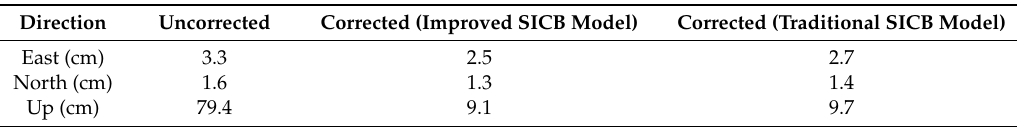
Table 2. Average positioning accuracy of single-frequency PPP with and without SICB corrections for all 24-h